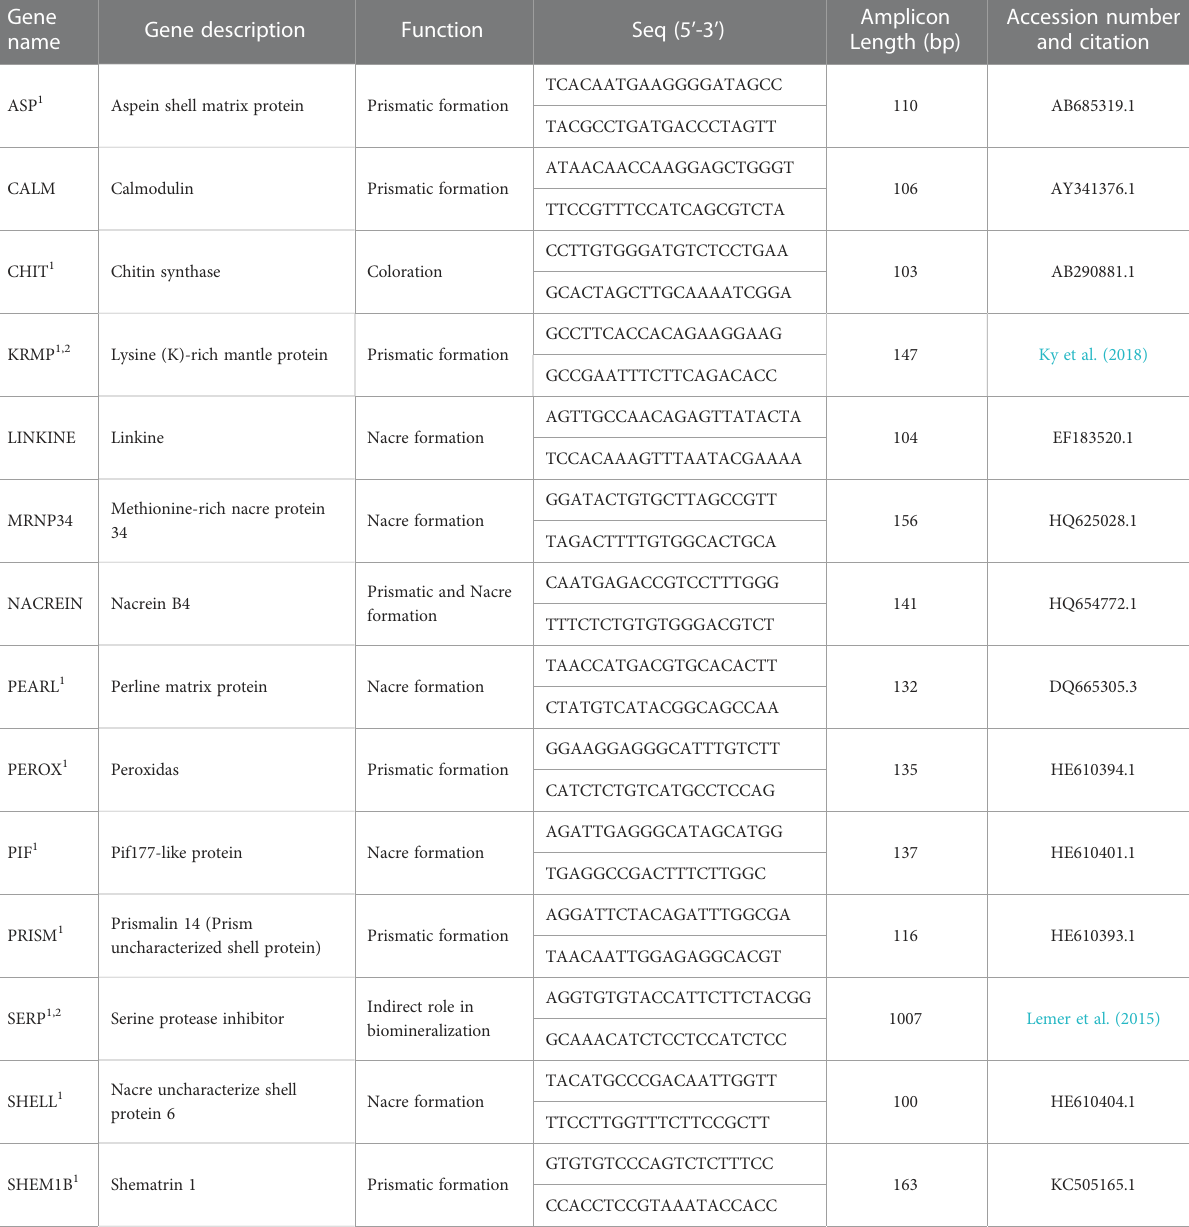
TABLE 1 Details of the candidate genes and the primer pairs used for gene expression analysis in Pinctada persica in this